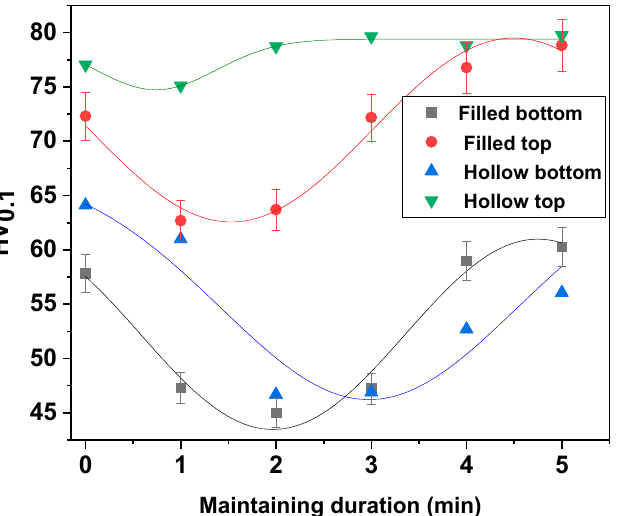
Figure 5. The microhardness obtained in the case of the sintering heat treatment at 900 °C.